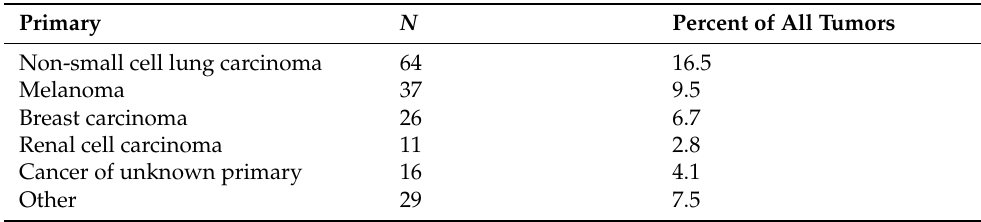
Table 1. Primary tumor of BM undergoing radiosurgery.